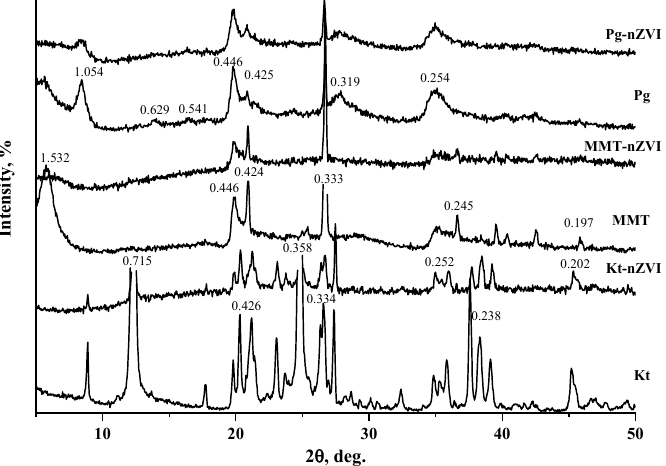
Figure 1. X-ray powder diffraction (XRD) patterns of pristine and nanoscale zero-valent iron (nZVI)—modified clay minerals.